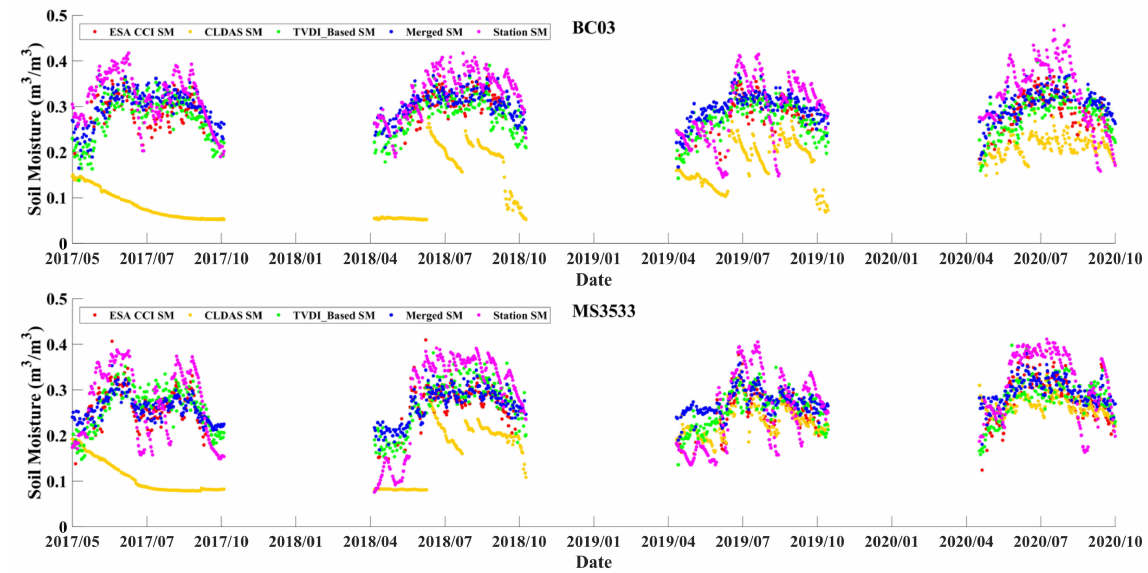
Figure 8. Temporal evolution of ESA CCI combined, CLDAS, TDVI-based, merged and in situ SM at BC03 and MS3533